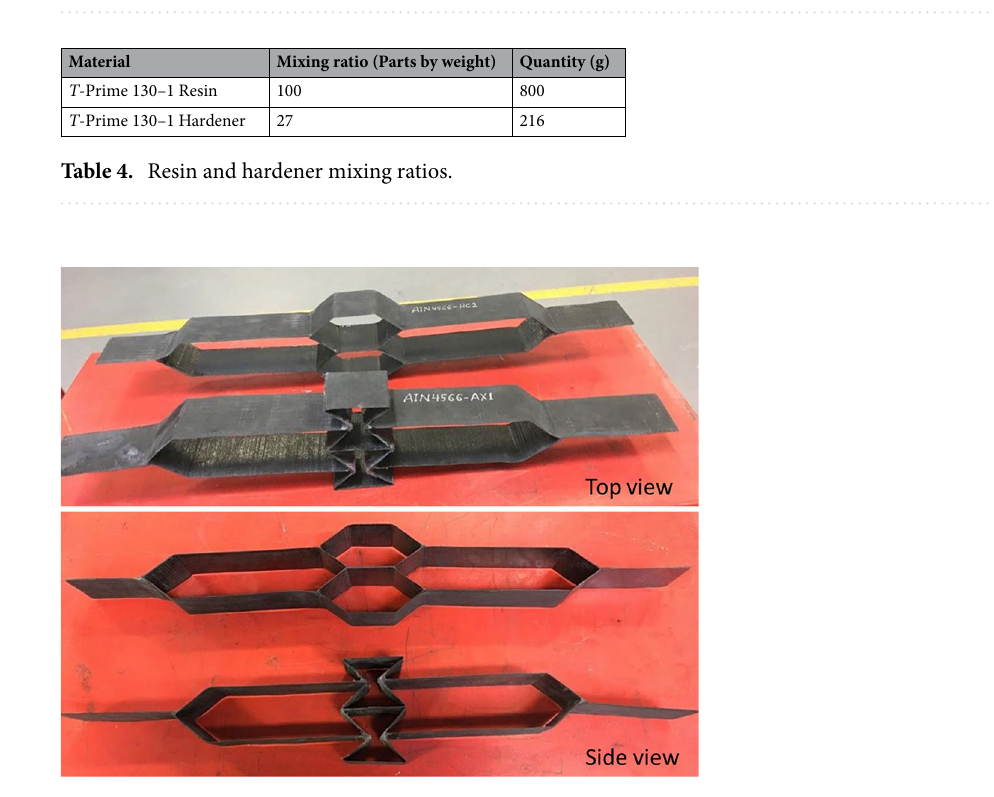
Figure 10. Cured honeycomb (top) and auxetic (bottom) composite